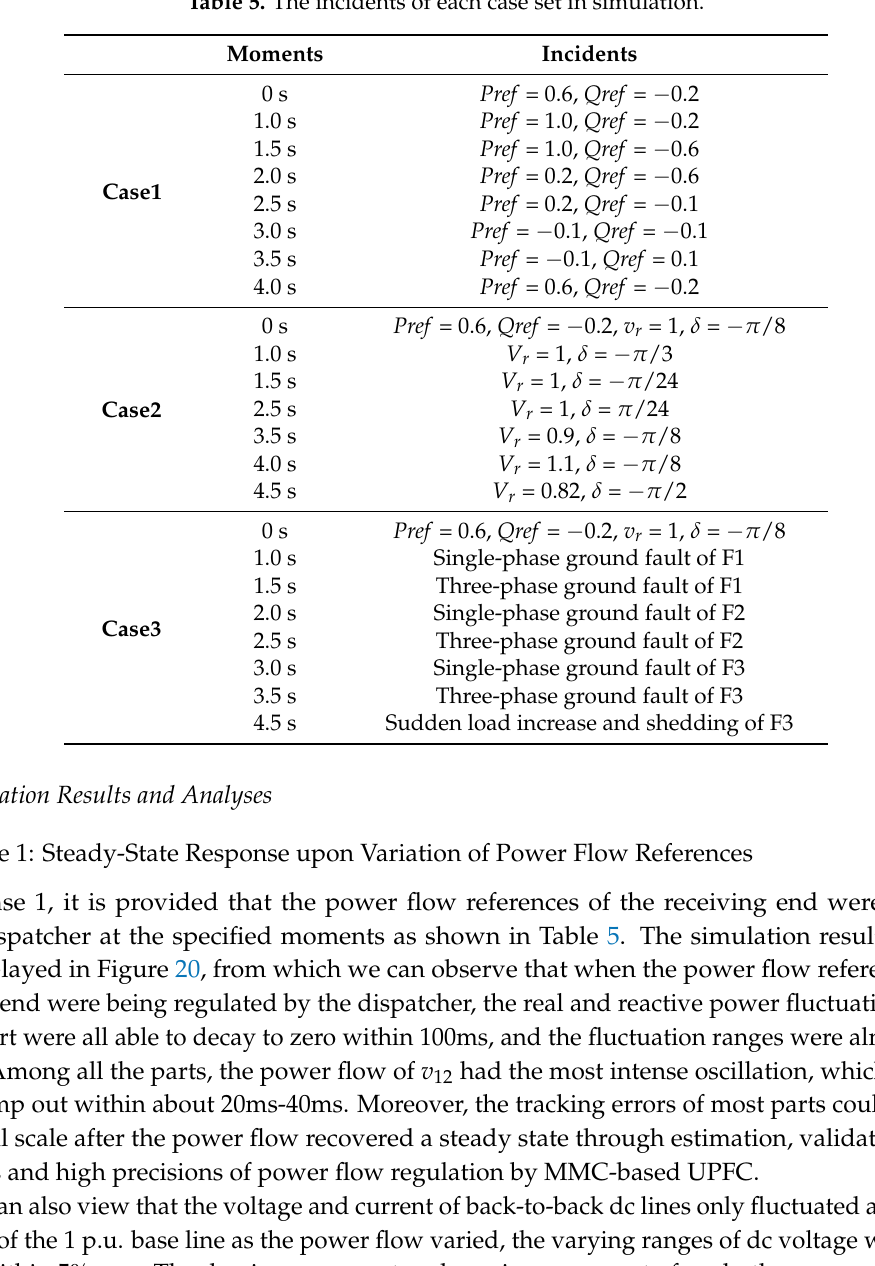
Table 5. The incidents of each case set in